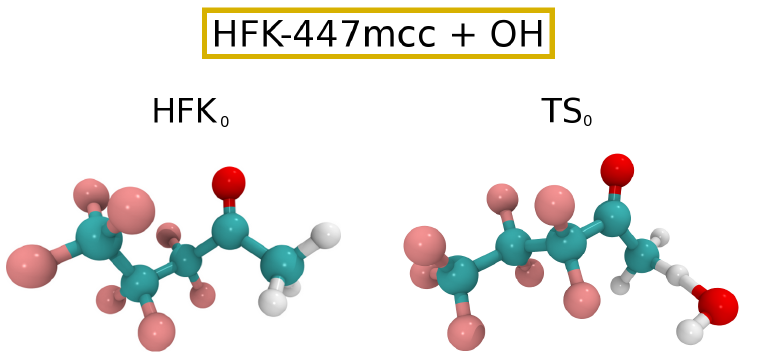
Figure 2. Ball and stick drawings for the lowest energy HFK-447mcc reactant and respective TS 0 for reaction (3).